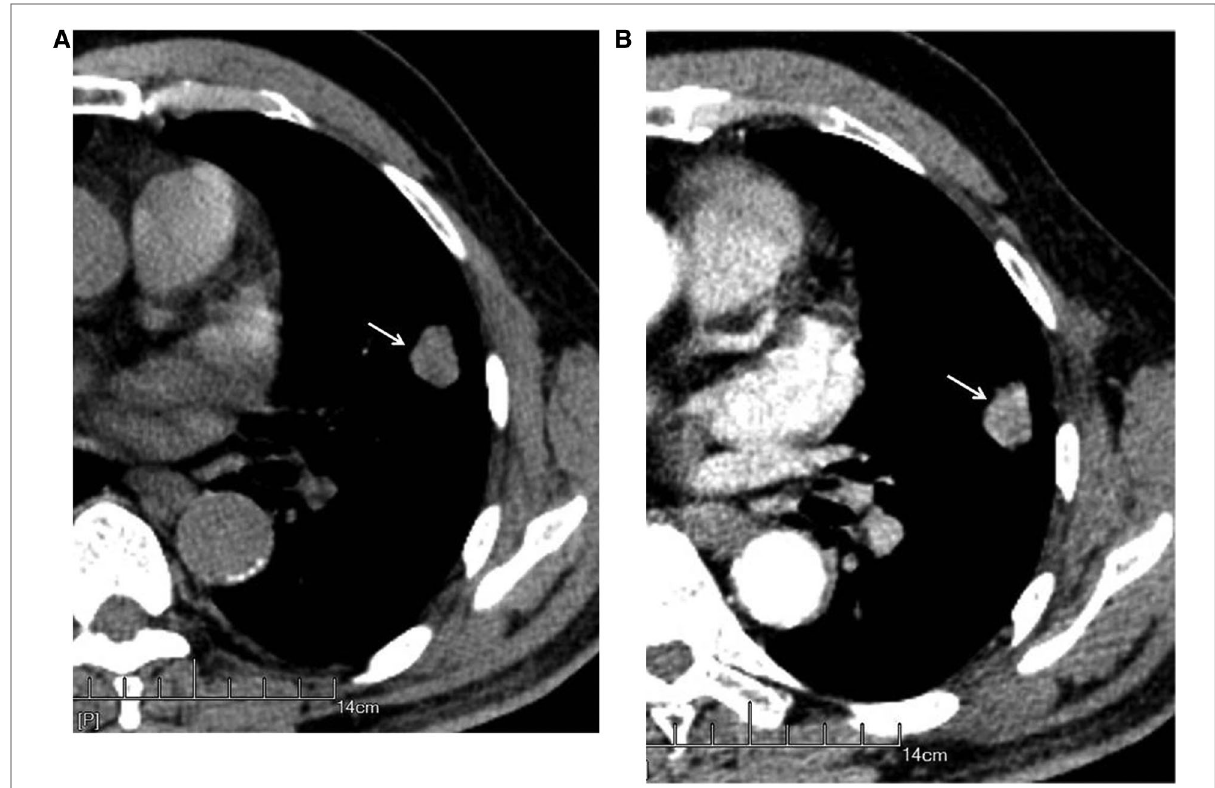
FIGURE 3 Male, 69 years old, with in fi ltrating adenocarcinoma in the anterior segment of the upper left lung (moderately differentiated degree) without hilar and mediastinal lymph node metastases. CT showed a solid nodule. The left fi gure ( A ) shows unenhanced imaging and a solid nodule (arrow), and the right fi gure ( B ) shows enhanced imaging and an enhanced nodule